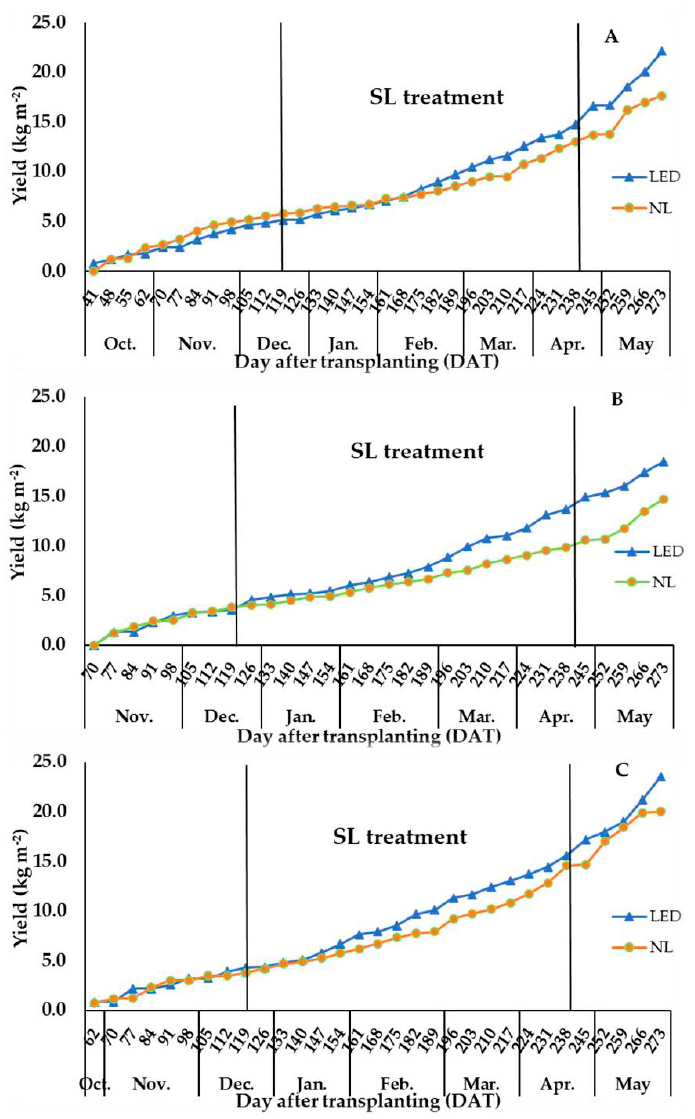
Figure 7. Cumulative trends of yield during the harvests. LEDs for SL treatment were switched on between 122 and 223 DAT. Each symbol represents the mean of six replications for ‘Solarino’ ( A ) and ‘Sorentyno’ ( B ) and of eight replications for ‘Juanita’ ( C ). Different symbols and colors represent different light treatments.